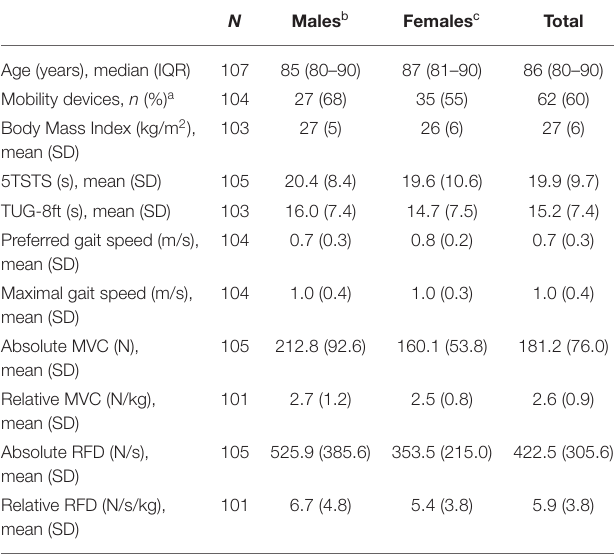
TABLE 1 | Participant’s